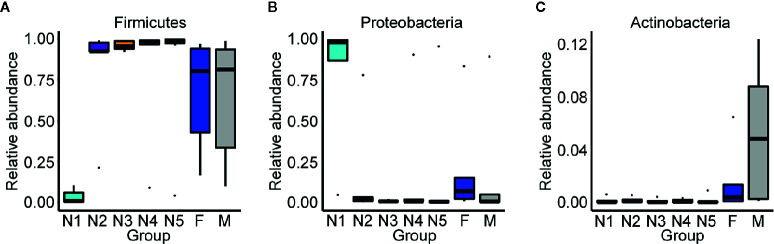
Relative abundances of the significantly altered 15 most important gut phyla across developmental stages of T. rubrofasciata. Each column represents one group (N1, 1st stage nymphs; N2, 2nd stage nymphs; N3, 3rd stage nymphs; N4, 4th stage nymphs; N5, 5th stage nymphs; F, female adult; M, male adult). The top and bottom whiskers indicate the maximum and minimum values, respectively, and the hyphen represents the median value. (A) Firmicutes. (B) Proteobacteria. (C) Actinobacteria.